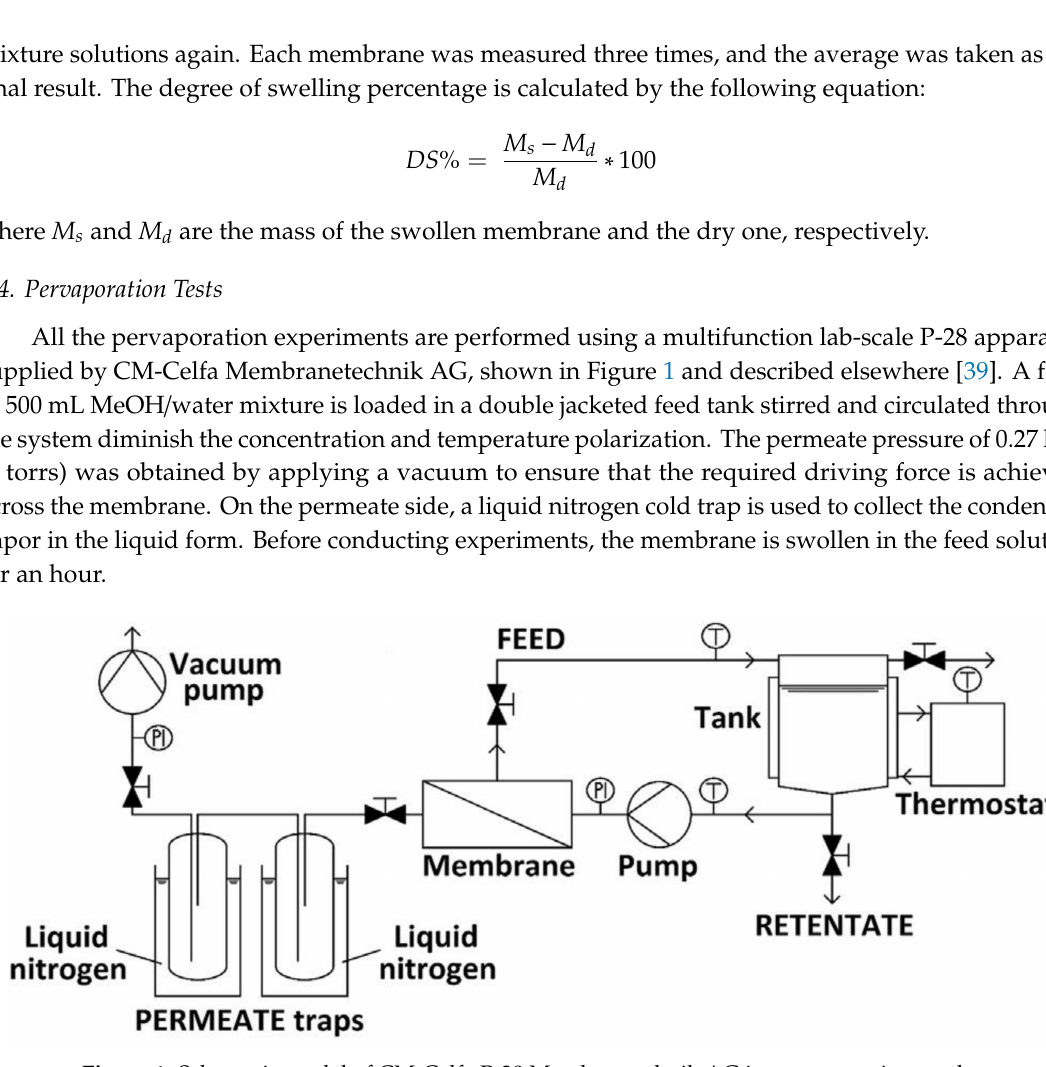
Figure 1. Schematic model of CM-Celfa P-28 Membrantechnik AG in pervaporation